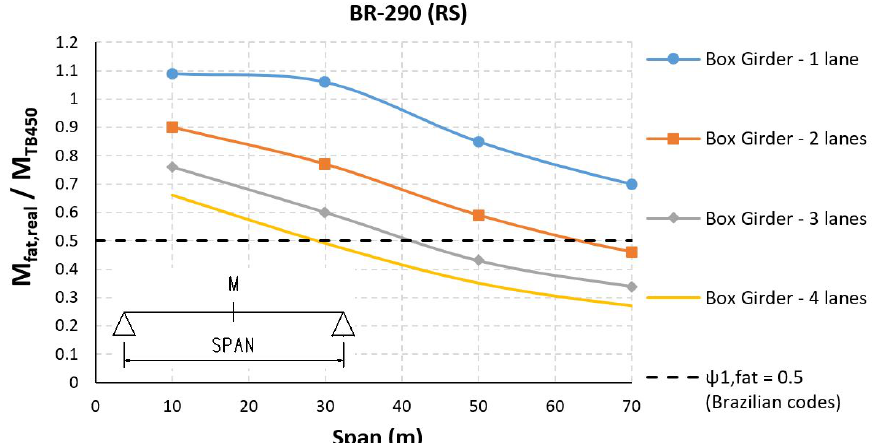
Figure 16. Bias factors for bending moment at mid-span in simply supported box-girder bridges – BR-290 (RS).